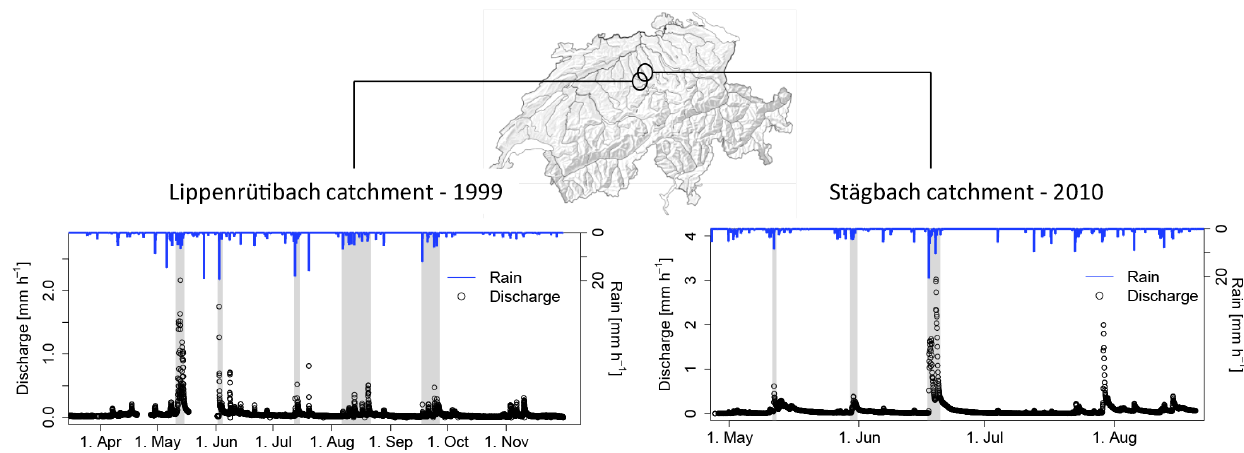
Figure 1. Location of study areas and the rainfall and discharge characteristics for the respective monitored year. Grey shading indicates the events for which discharge was calculated using the dominant runoff processes approach.